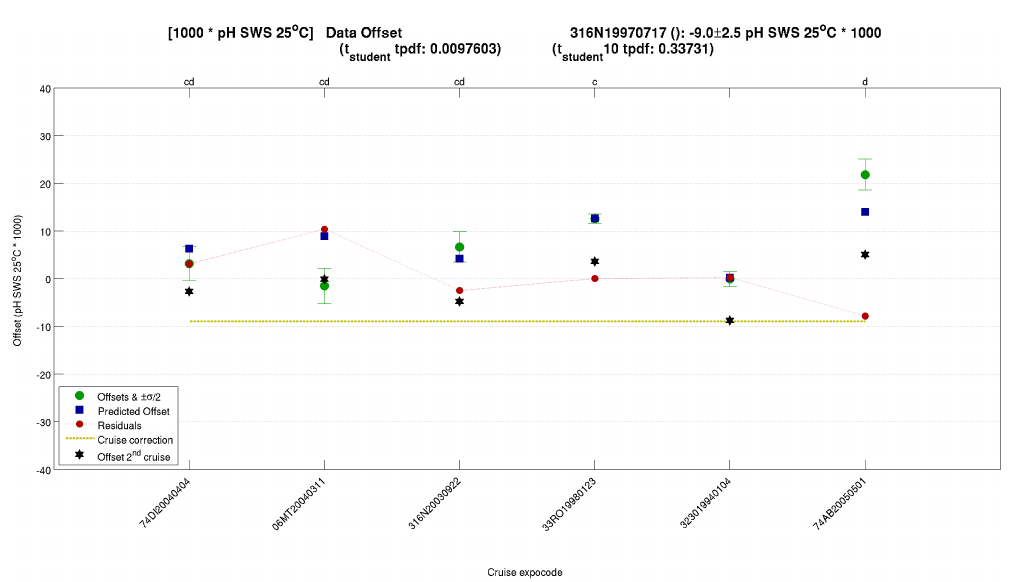
Figure 22. Cruise crossover information plot for 316N19970717. 44 full depth stations sampled with a 24 position rosette sys- tem. The cruise has 22 crossovers. The inversion suggests a correction of 0.018 ± 0.001. Except two, all residuals are low and fit inside ± 0.005 after the full solution of the inversion is applied. Good fit also exists with 8 core cruises. Based on this evidence, an adjustment of 0.018 was applied to the pH